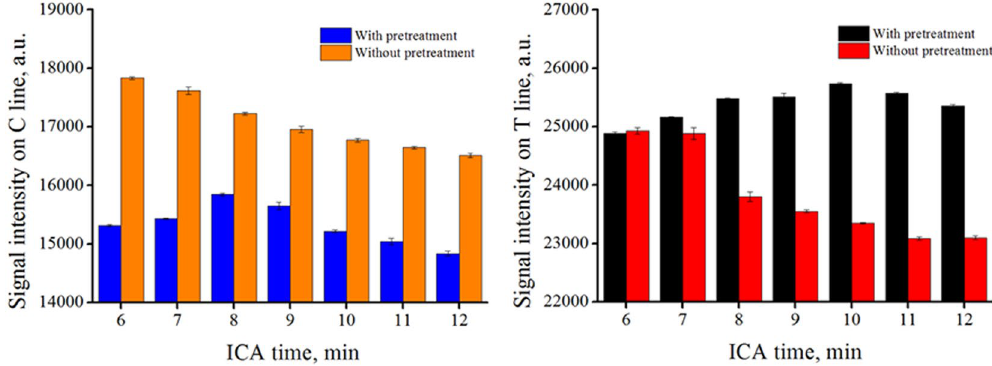
Figure 4. T and C line values of samples with and without pretreatments. The commercialized ICA results were readout in 6–7 min. In the bar chart, the T and C line values without pretreatment decreased obviously after 8 min. By contrast, for the sample with pretreatment, the T line value remained relatively stable in 8–12 min, whereas the C line value remained relatively stable in 6–10 min. A high T line value and a low C line value were obtained after pretreatment for zearanol spiked